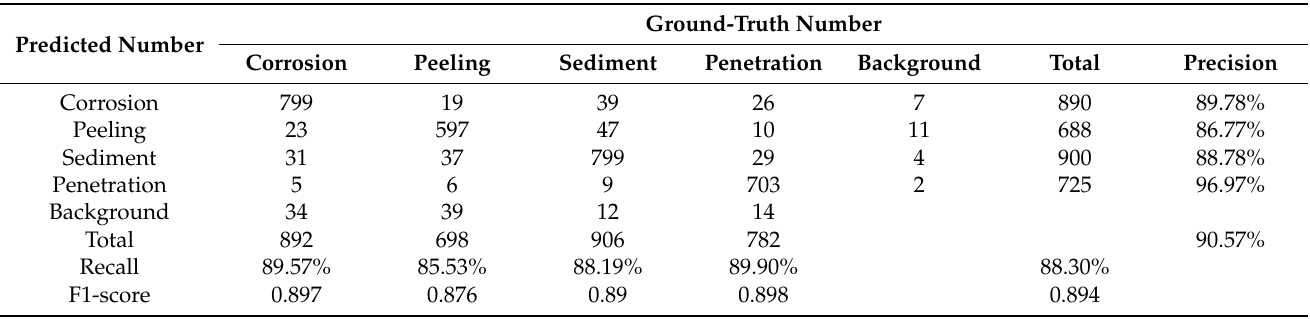
Table 8. Defect detection results of YOLO v5 without attention mechanism.